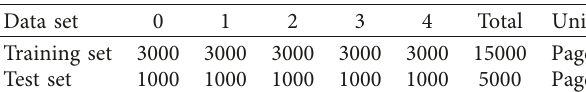
Table 3: Experimental dataset.